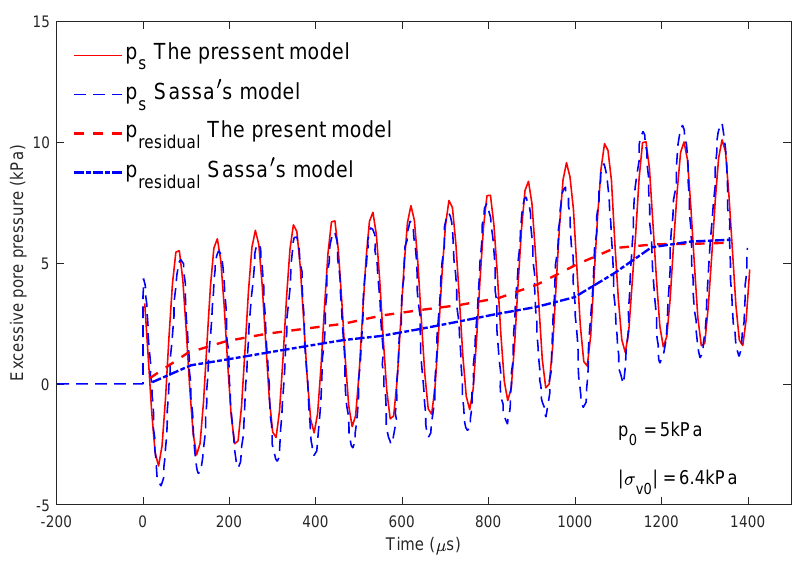
Figure 6. Excess pore pressure at point A subject to progressive wave loading. Notation: red lines = the present model, blue lines = Sassa’s model